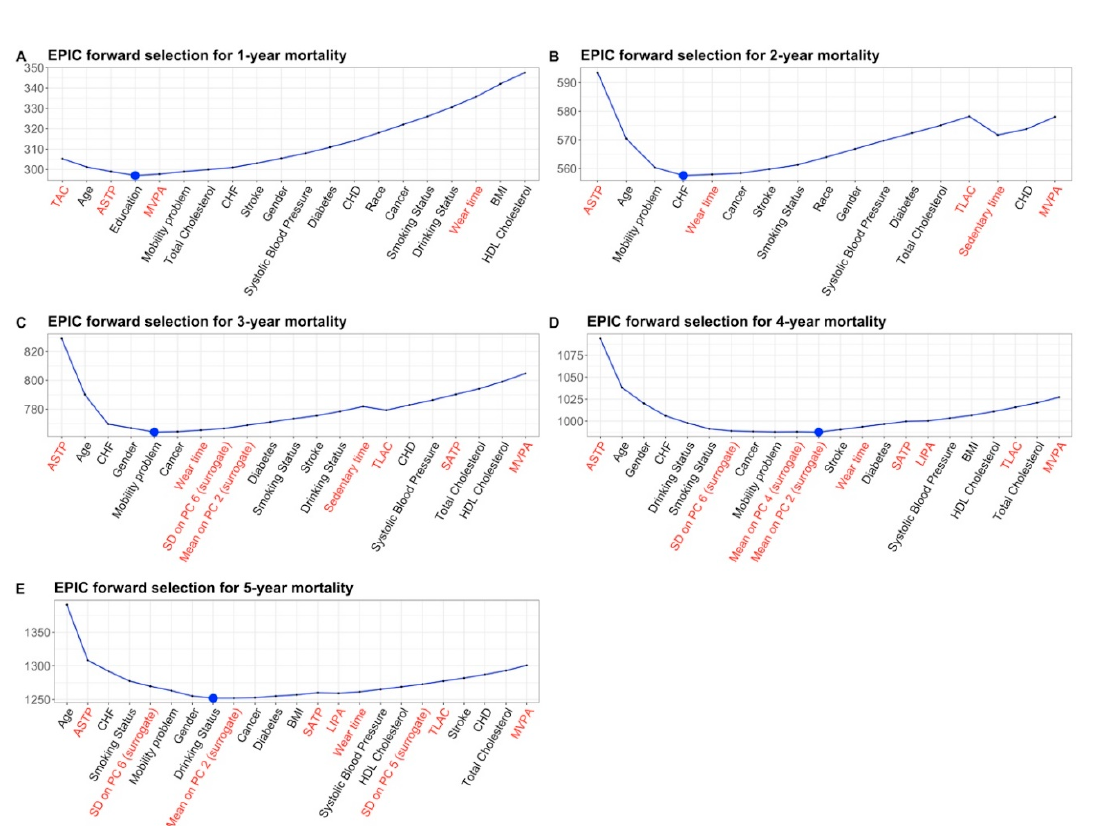
Figure A1. Multivariate models for one- to five-year all-cause mortality plotted as a function of the forward selection procedure. Accelerometry predictors are shown in red on the horizontal ax-is. NHANES Pooled Cohorts Study, United States,